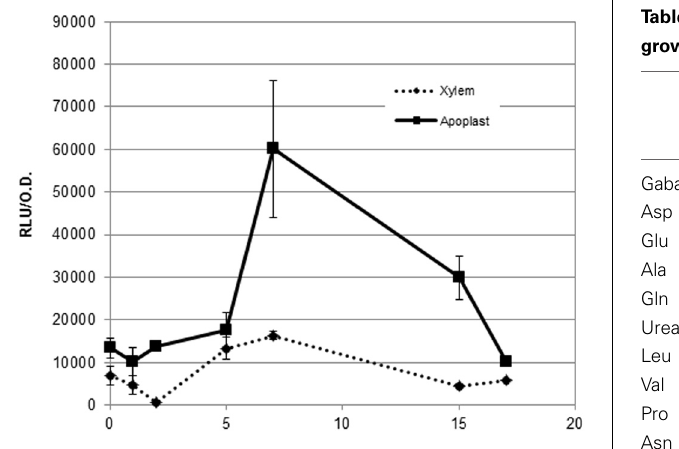
FIGURE 4 | Expression profile of the hrpG promoter in both apoplast and xylem exudates. Induction of the hrpG promoter in bacteria grown in cell-free plant exudates. A representative result using three biological replicates is shown. Promoter output is presented as relative luminescence units (R.L.U) produced by the lux reporter corrected by cell density estimated by OD 600 . Error bars indicate standard deviations.